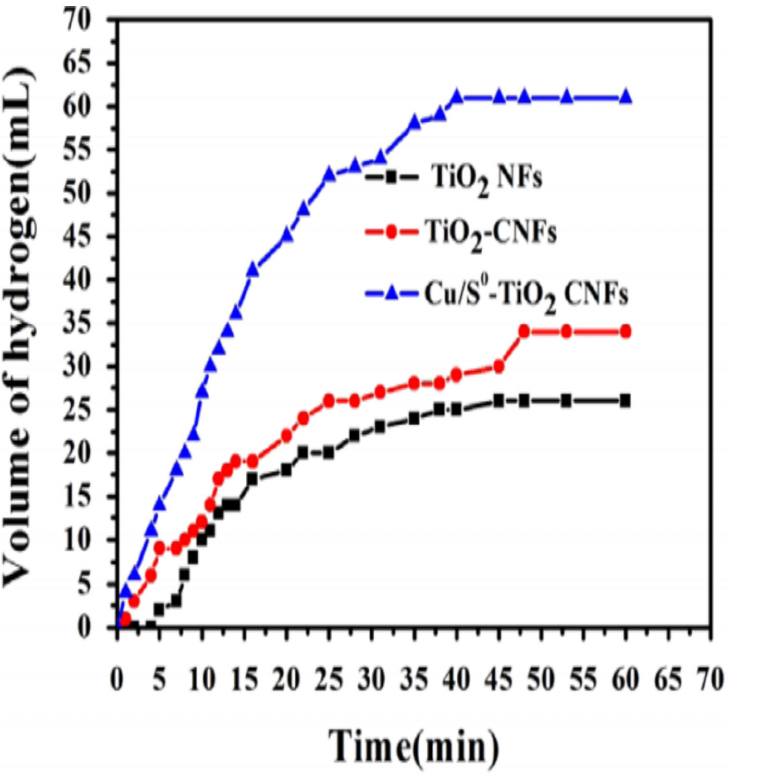
Figure 20. Photocatalytic performance of TiO 2 NFs with and without Cu/S for AB hydrolysis reaction. Reprinted from reference [8] with permission from